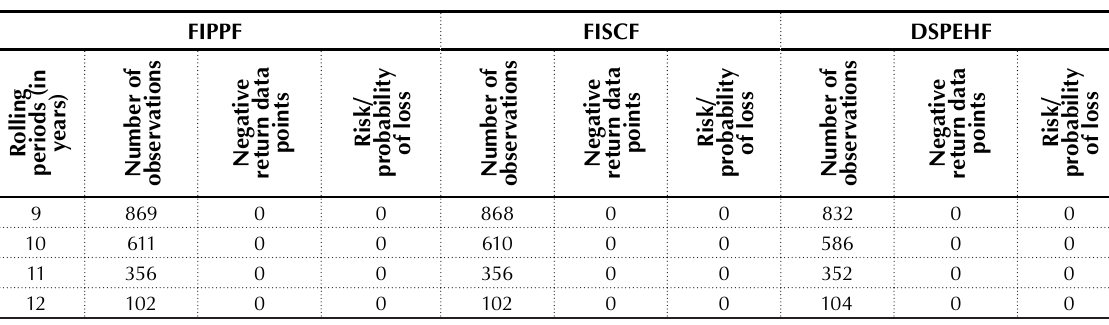
Table 16 (cont.). Rolling period risk and return behavior of FIPPF, FISCF and DSPEHF